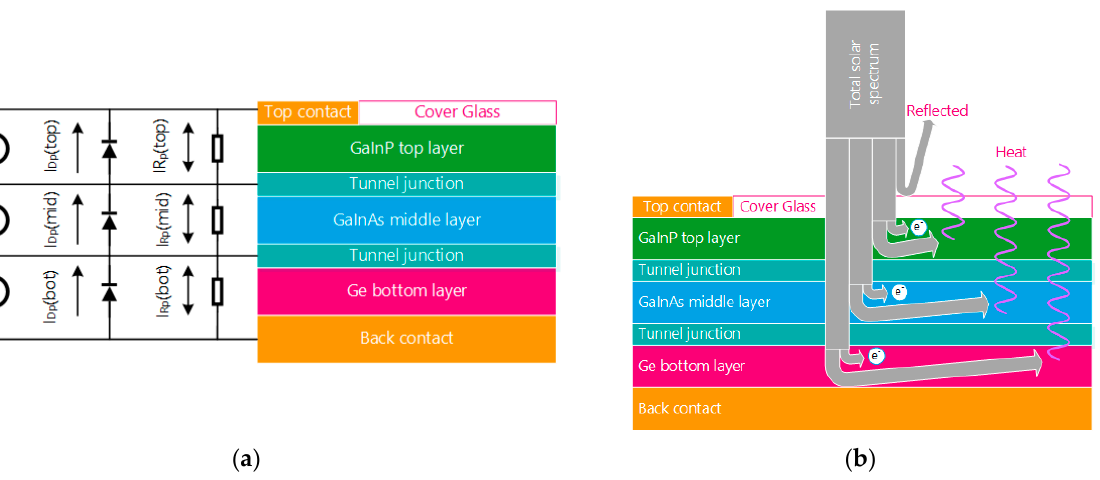
Figure 3. ( a ) Series model of GaInP/GaInAs/Ge solar cell and its equivalent circuit. ( b ) Energy distribution of solar irradiation.